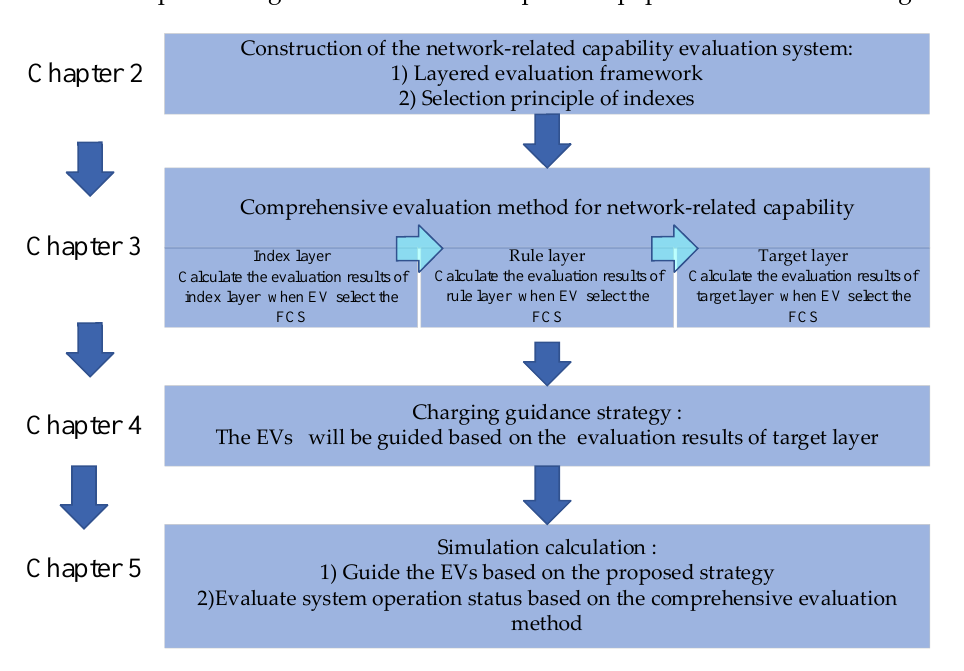
Figure 1. The chapter arrangement and relationship